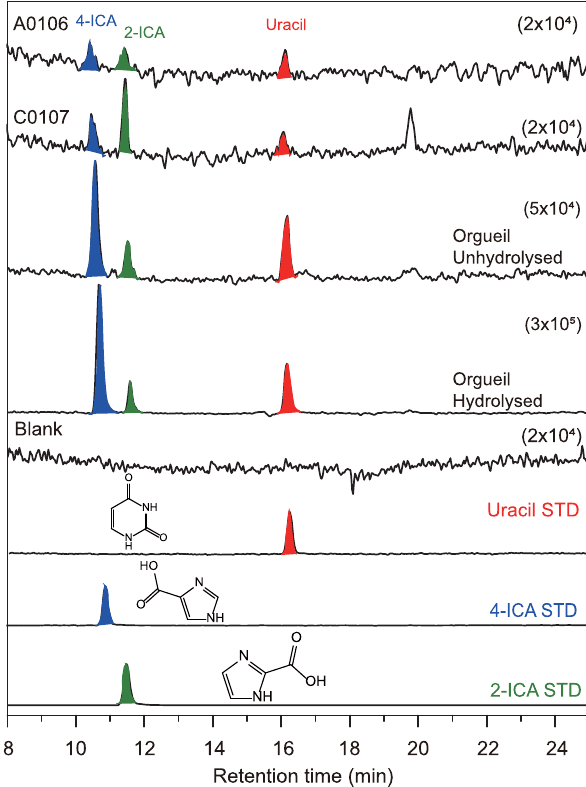
Fig. 4 | Uracil (C 4 H 4 N 2 O 2 ) with their structural isomers detected in Ryugu A0106 and C0107 samples and Orgueil meteorites. Mass chromatograms at the m/z of113.0346whichcorrespondstotheprotonatedionofexactmassnumberfor uracil in the acid hydrolysate of the hot water extracts from the A0106 and C0107 samples. For Orgueil, mass chromatograms measured before and after acid hydrolysis were also shown. Datafor the blanksampleand authentic standards are also shown for comparison. Numbers in parenthesis represents the range for the vertical-axis in the sample